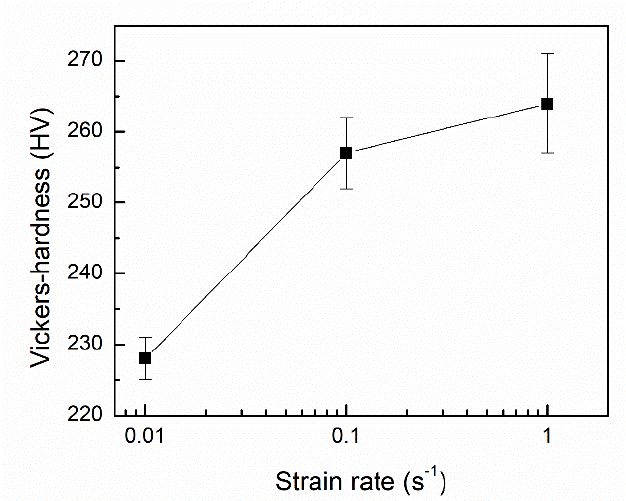
Figure 19. Vickers hardness of the low-carbon ferritic stainless steel samples with the different strain rates.